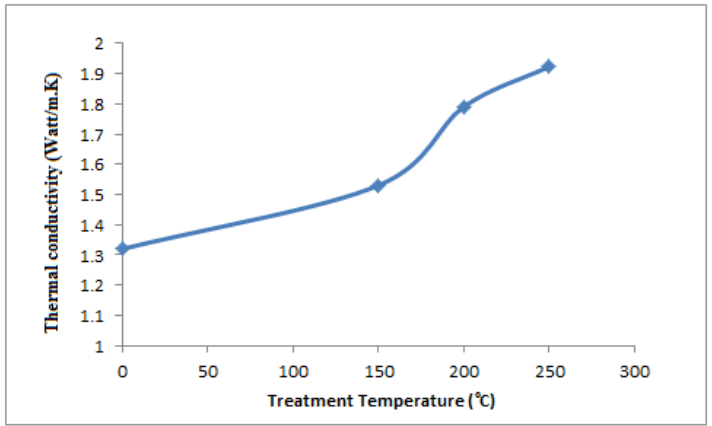
Fig.4: Thermal conductivity of Ep/Cu coated CF composites at different treatment temperatures (150, 200, 250) o